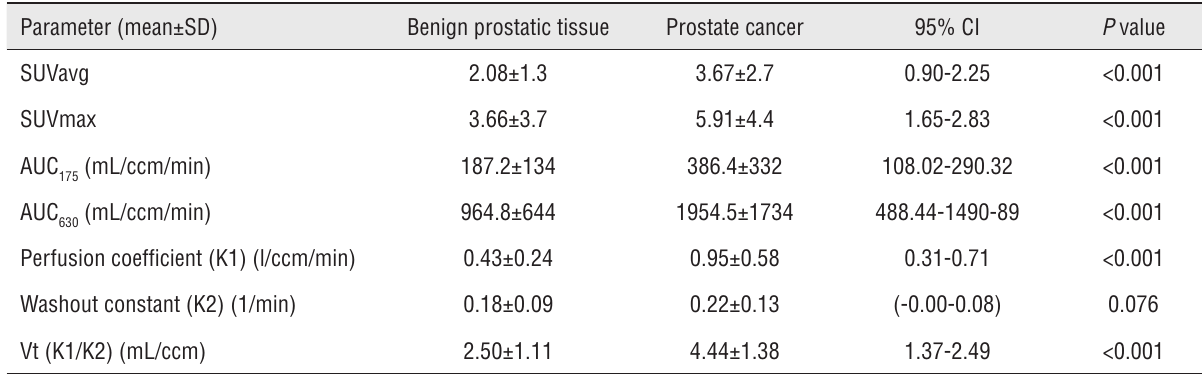
Table 2 - comparison of 11 c choline pET/cT parameters between prostate cancer and benign prostatic tissue. Parameter